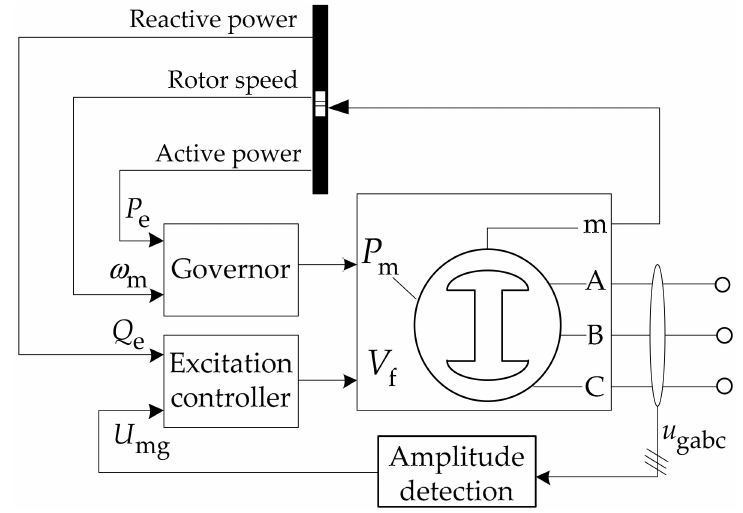
Figure 5. The synchronous grid model.